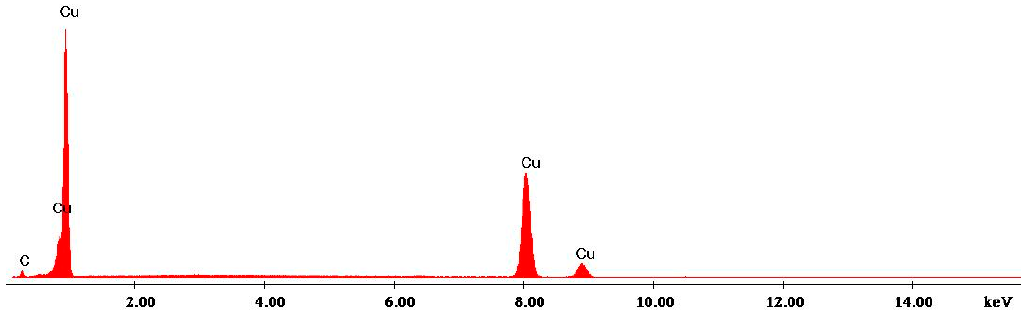
Figure 38. BSE images of a sealing wax red-colored glass, with ( a ) details of the vitreous matrix and ( b ) micrometric inclusions in the shape of dendrites (SP5 orange/red plant ash-based glass tessera from the Basilica of St. Peter, Rome, Italy [26]).